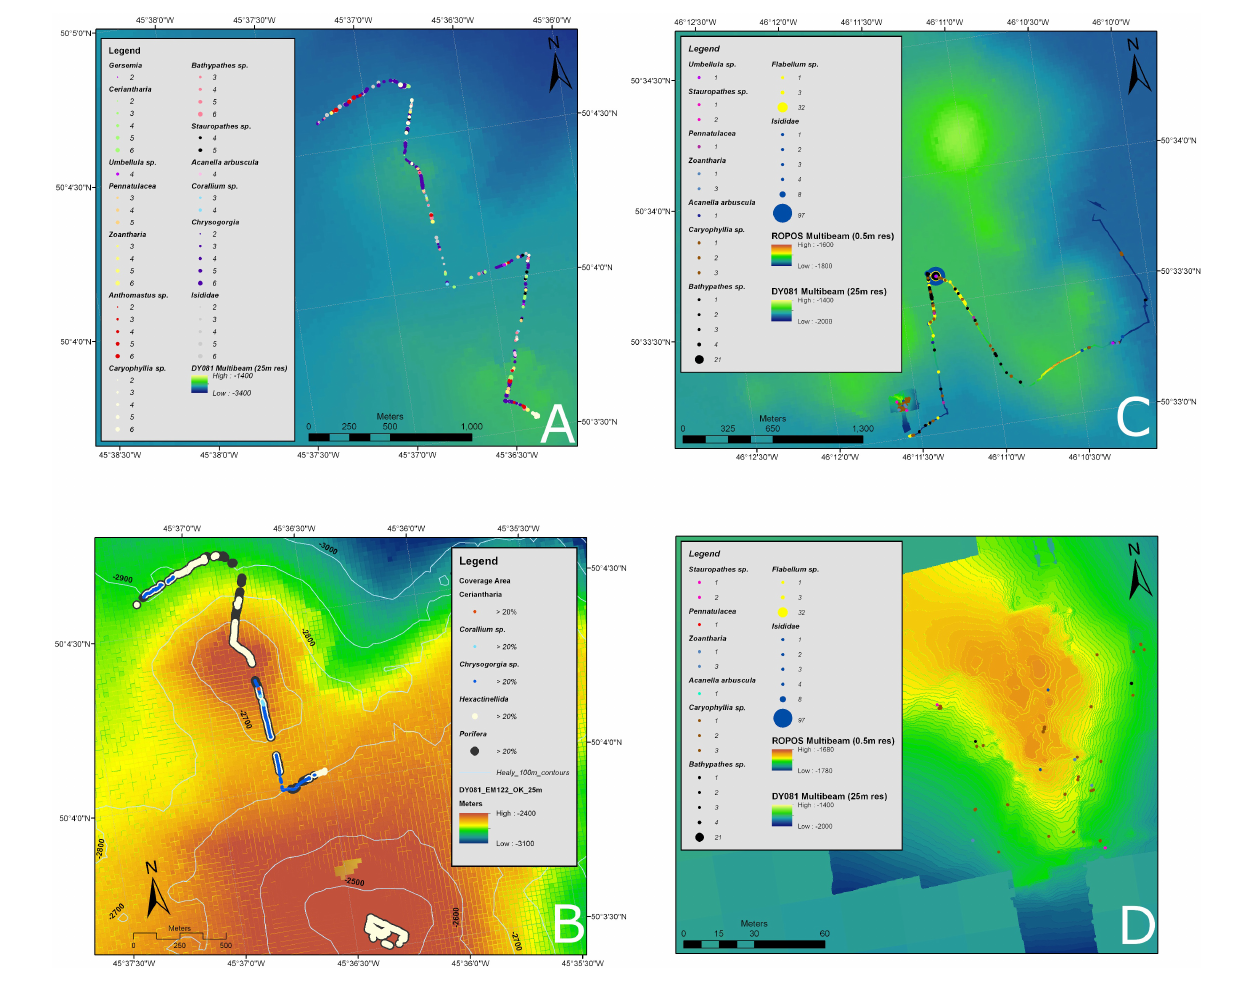
FIGURE 12 | Distribution of cold-water coral observations along ROPOS dives. (A,B) Coral observations on SE Orphan Knoll dive R1341. (A) Coral observations. (B) Locations of faunal concentrations of corals and sponges > 20% cover. See Figure 9A for surficial geology layer. (C,D) Coral observations on NE Orphan Knoll dive R1343. (C) Coral distributions throughout dive R1343. See Figure 9B for the surficial geology layer. The track of the ROV showing coral occurrences is overlaid over DY081 bathymetry. Coral abundances not adjusted for area observed. White box indicates location of (D) . (D) Coral observations surrounding bedrock outcrop mapped in Figure 8C , including Desmophyllum dianthus coral graveyard. See Figure 9B for surficial geology layer, and see Figure 7C for underlying ROV-derived bathymetry below (D)